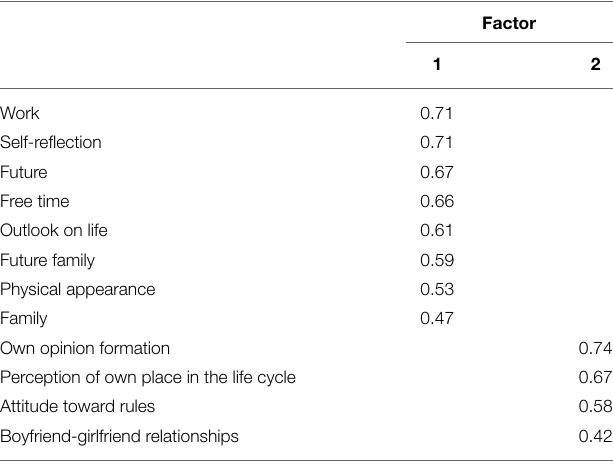
TABLE 3 | Loadings of EIES scales on the factors obtained in exploratory factor